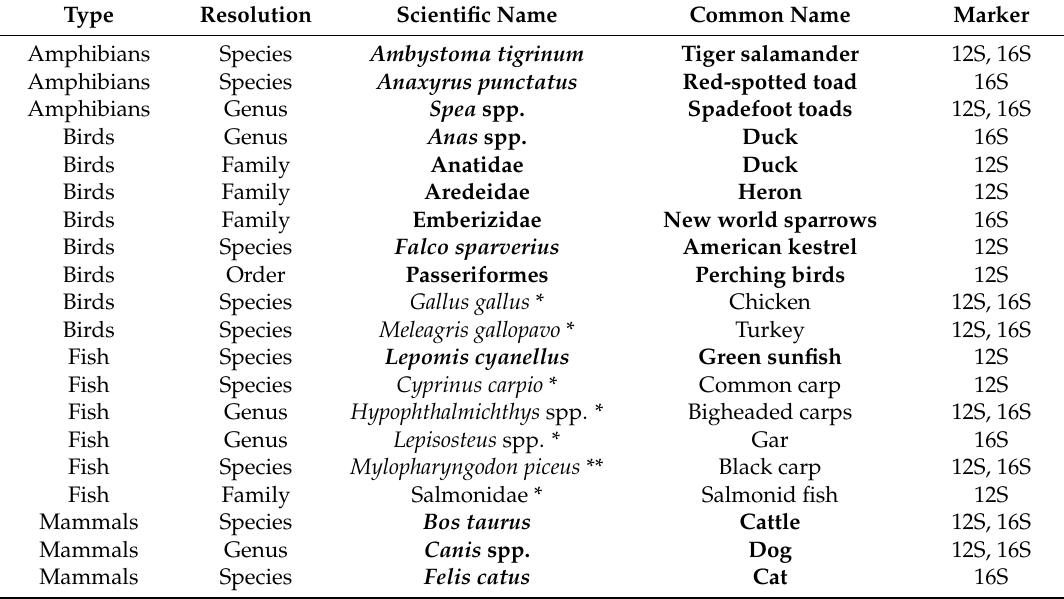
Table 4. Taxon identification and resolution from all samples using both 12S and 16S